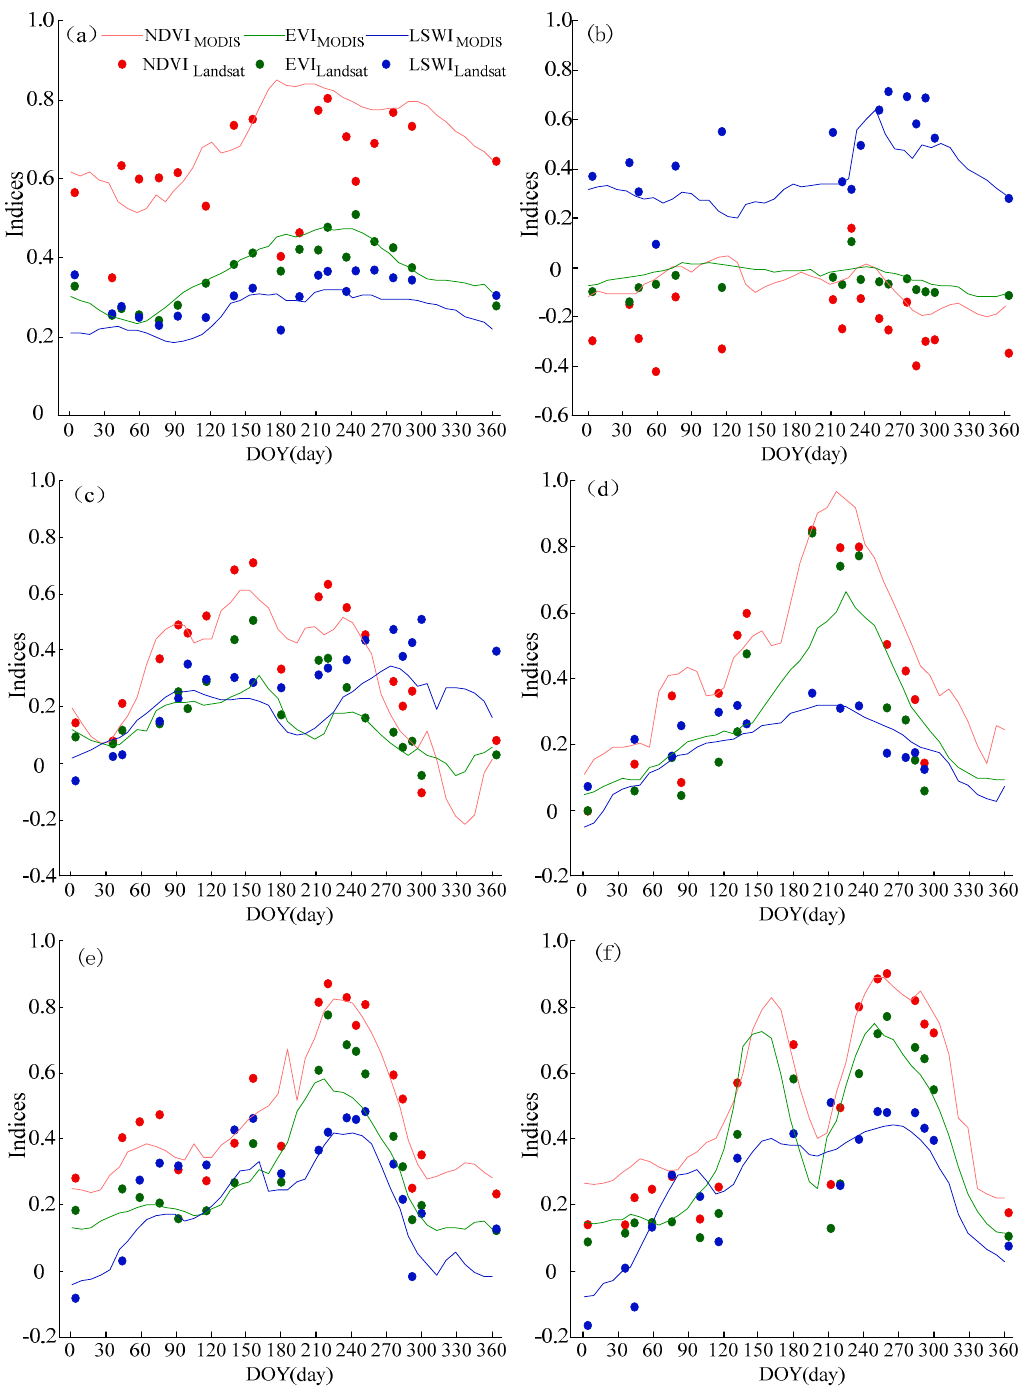
Figure 6. As in Figure 5, but for the seasonal dynamics of NDVI, EVI, and LSWI of the major land-cover types from fused Landsat–MODIS data.